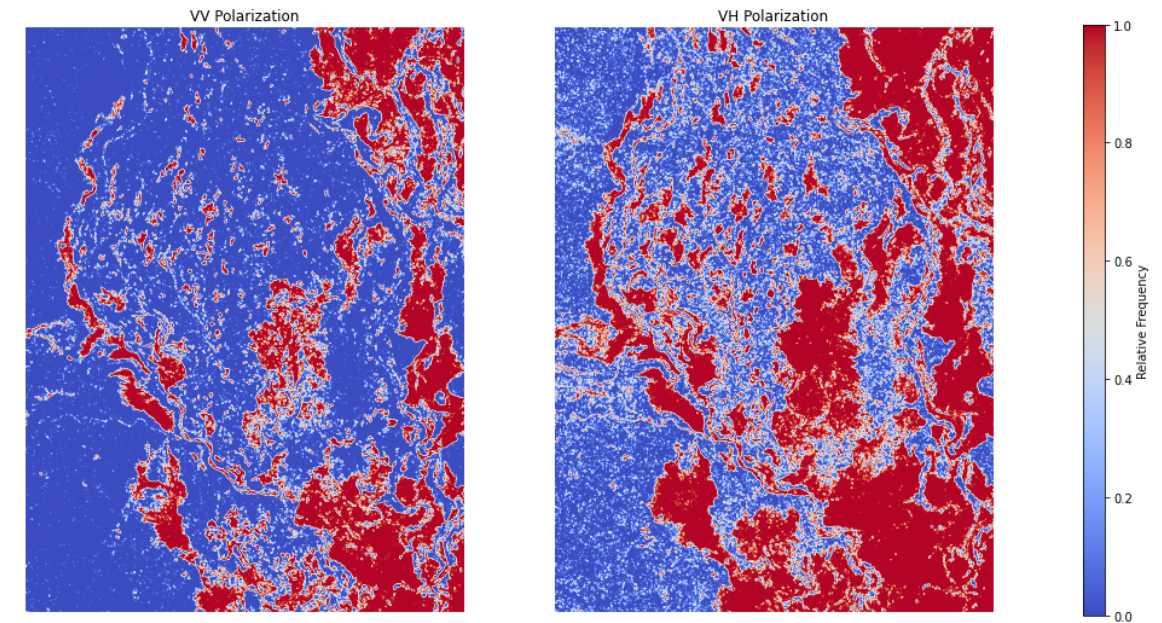
Figure 16. Mozambique Flood Relative Frequency for VV polarization ( left ) and VH polarization ( right ).